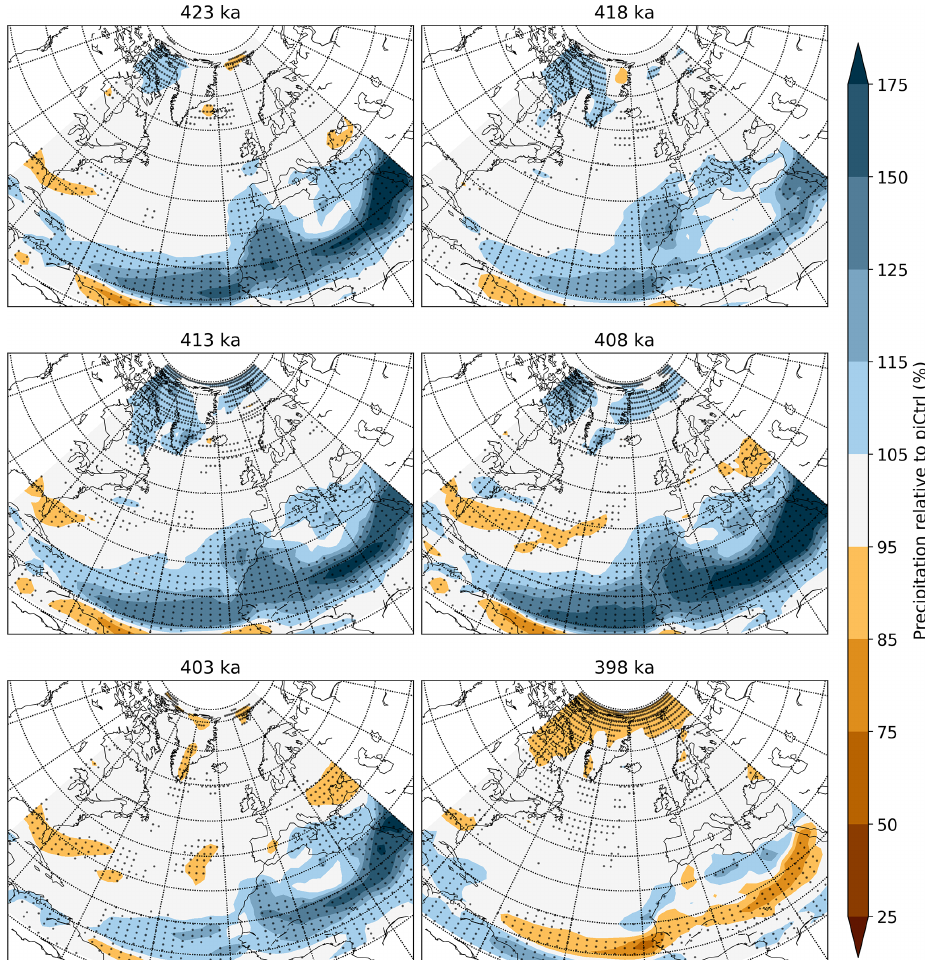
Figure 11. As in Fig. 10, but for the annual mean period.